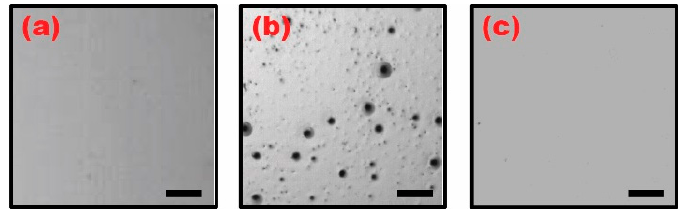
Figure 4. Microscopic images of the three different dip-coated samples. ( a ) An ion gel layer was dip-coated with the gel solution prepared with a high concentration of the ionic liquid (IL) at a 4:1 weight ratio with the copolymer (CP) and cured at 70 °C. A uniform surface quality is observed; ( b ) A Teflon layer is subsequently dip-coated over the gel layer and cured at 110 °C. Serious surface defects are observed; ( c ) For comparison, a pure Teflon layer was separately dip-coated and cured at 110 °C. No surface defects are observed. The scale bar represents a 0.5 mm length.